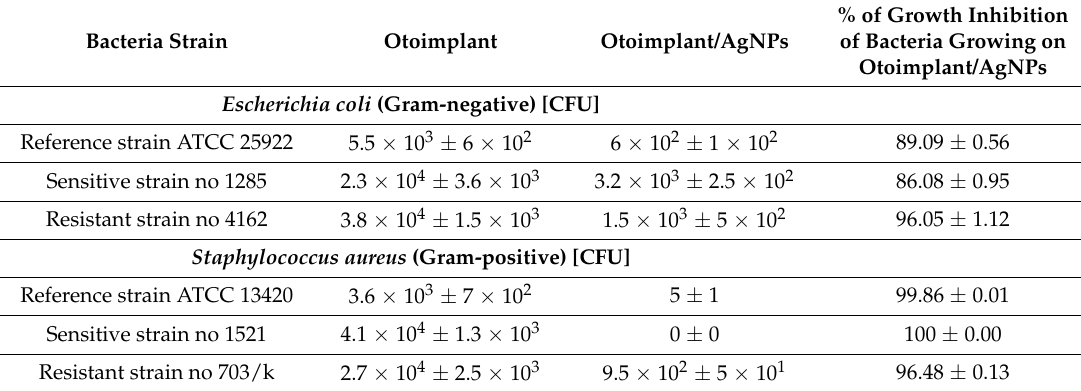
Table 2. Antimicrobial efficacy of the Otoimplant and Otoimplant/AgNPs. CFU – colony-forming unit. Bacteria